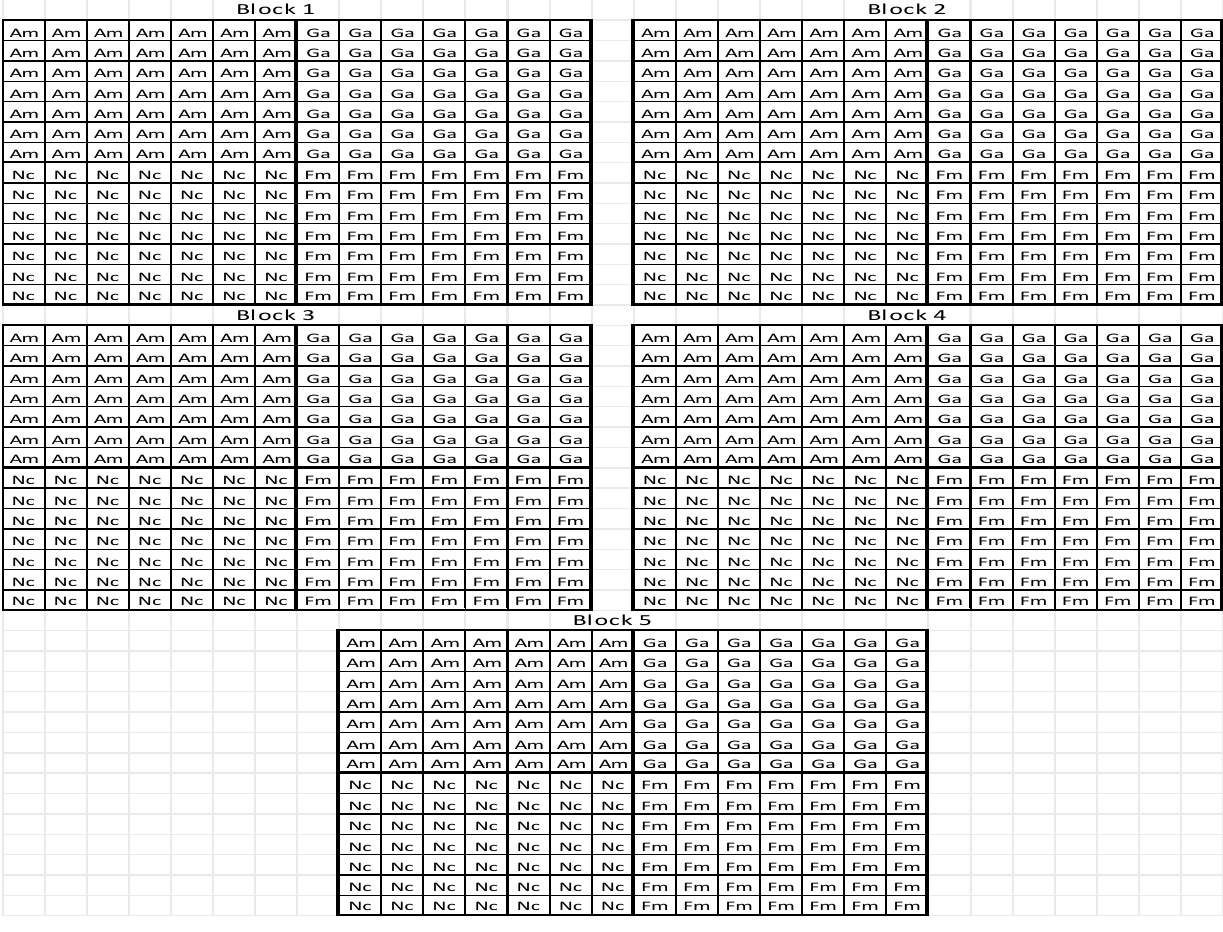
Figure 2. Experimental design of 4 fast tree growing species in community forests. (Fm: Falcataria moluccana ; Ga: Gmelina arborea ; Am: Acacia mangium ; and Nc: Neolamarckia cadamba ) .